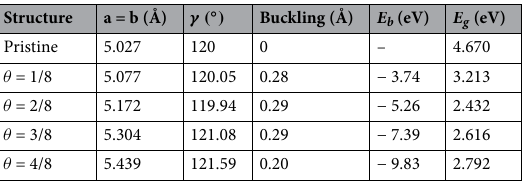
Table 1. Relaxed structural parameters for pristine hexagonal boron nitride and four different percentage of oxygen